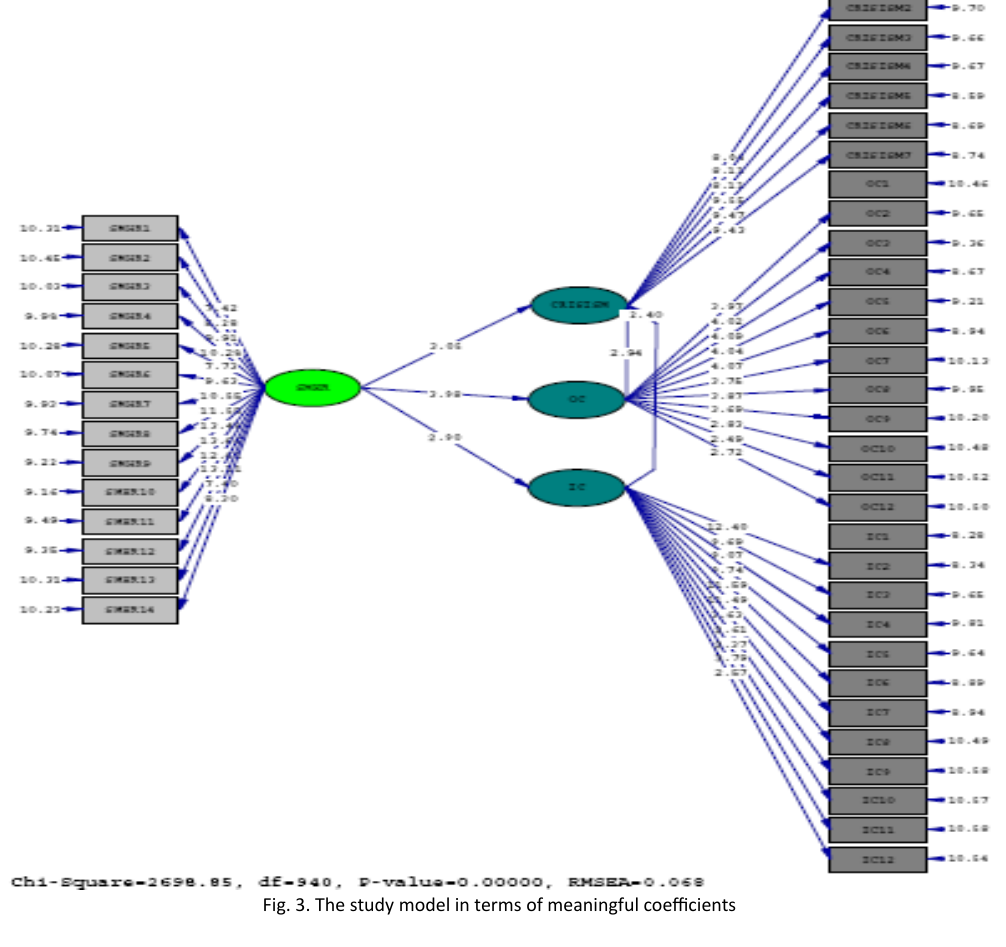
Fig. 3. The study model in terms of meaningful Fig. 3: The study model in terms of meaningful coefficients